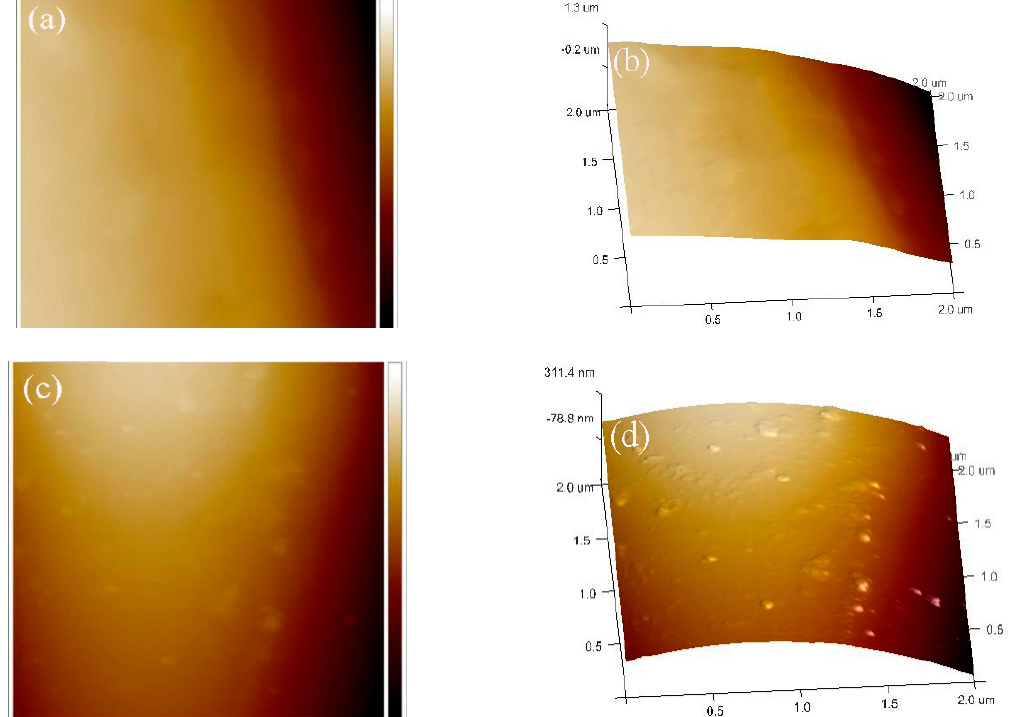
Figure 3. FTIR ( a ) and XPS ( b ) spectra of the coated quartz fiber.